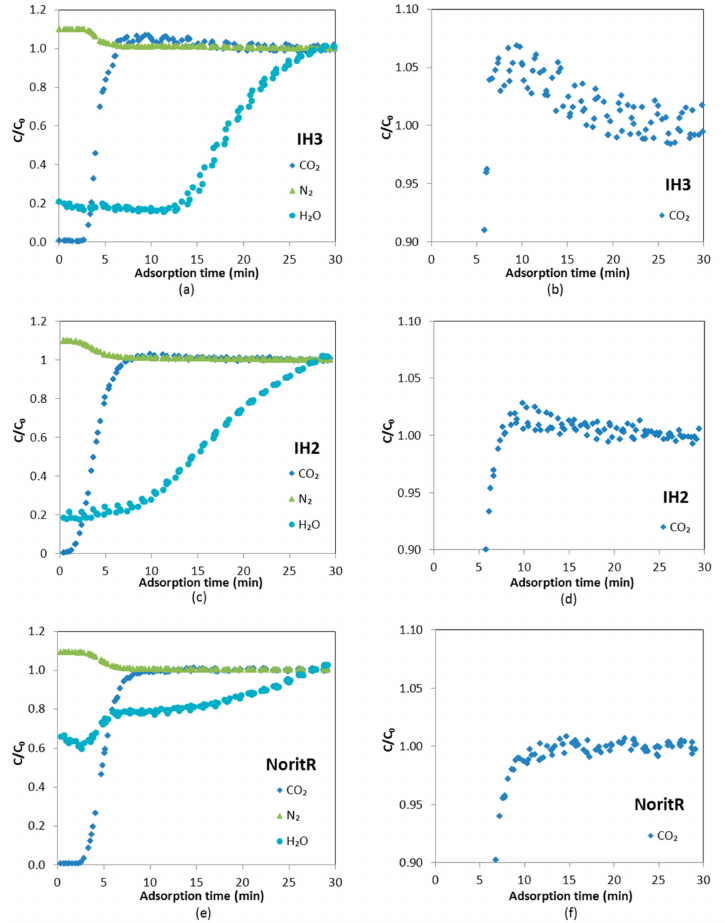
Figure 9. Comparison of N 2 , CO 2 and H 2 O concentration profiles during the ternary experiments with a CO 2 /N 2 /H 2 O mixture (8/90/2 vol %) for: ( a ) IH3; ( c ) IH2; and ( e ) Norit R at 50 ◦ C for the fourth to eight consecutive cycles; and detail of the CO 2 breakthrough curves over adsorbents: ( b ) IH3; ( d ) IH2; and ( f ) Norit